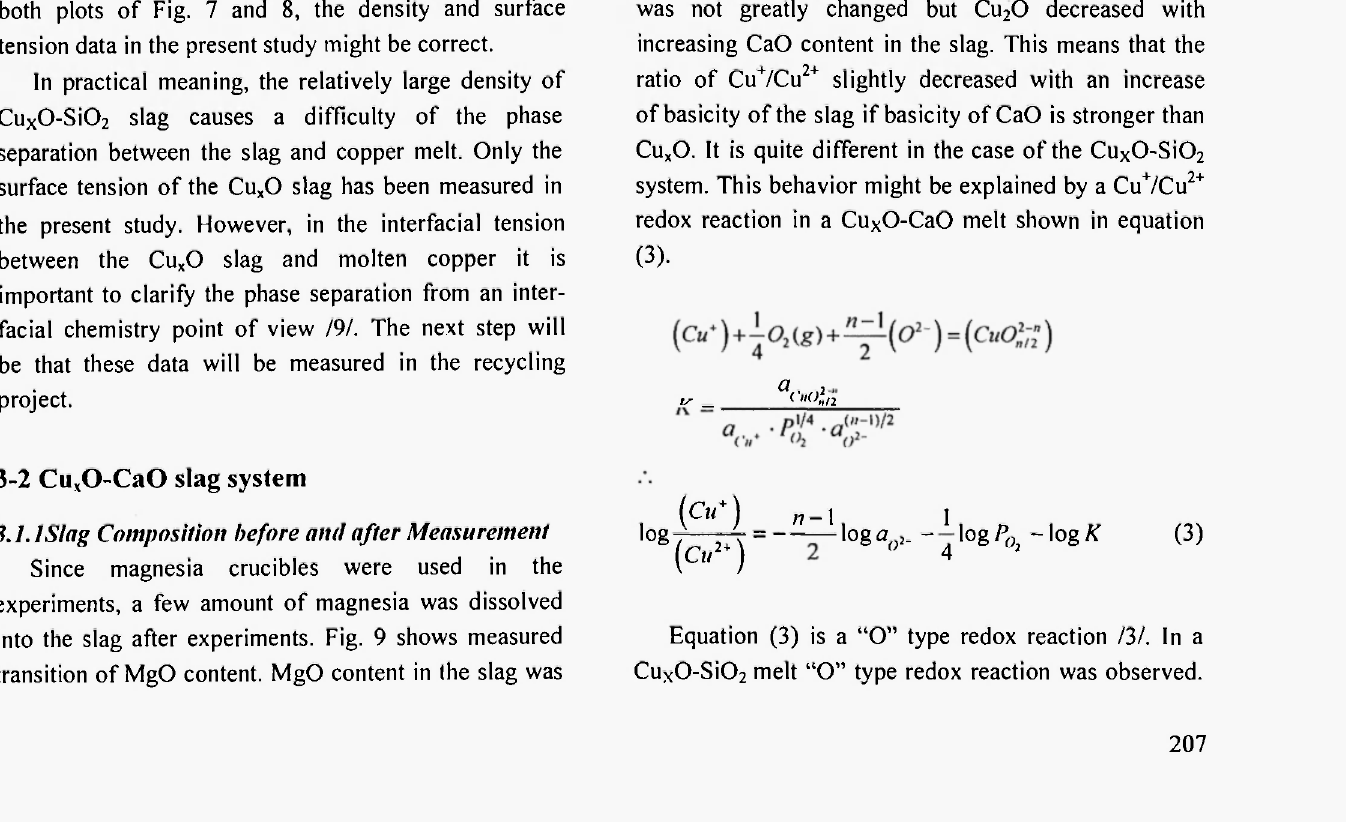
Fig. 8: Composition dependence of surface tension in various binary silicates melts 111 pure oxides lower than Si0 2 , for example, PbO, the surface tension of the binary silicates increases with an increase of Si0 2 content.